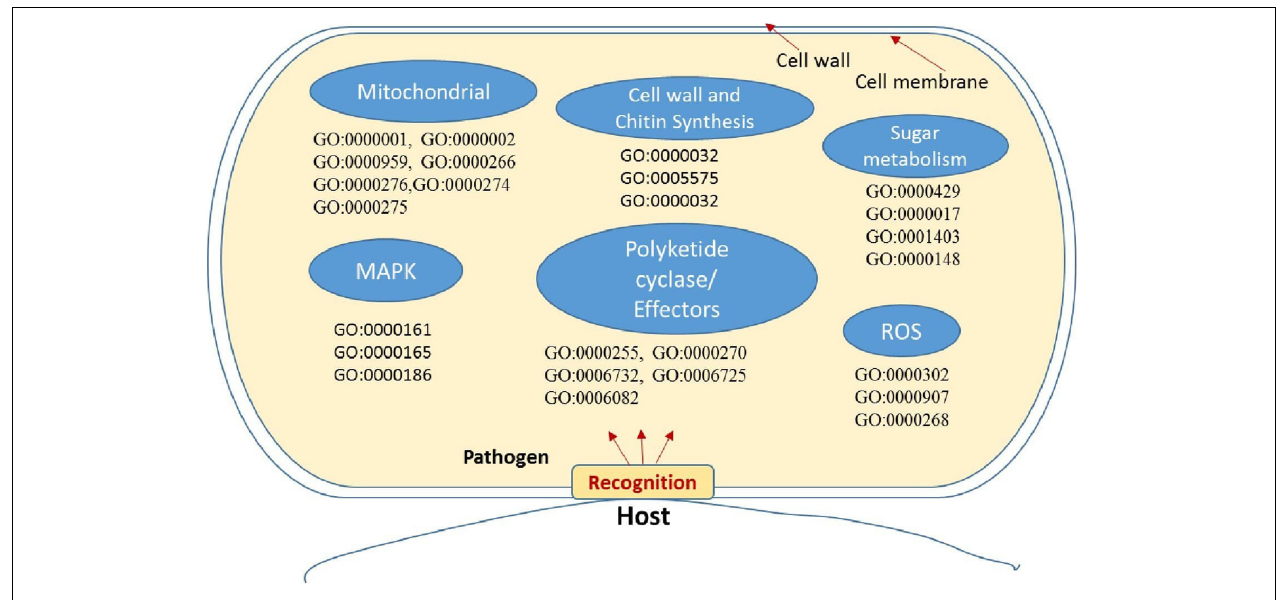
FIGURE 7 | Putative representation of possible activation of genes and GO enriched terms in fungal pathogen Bipolaris maydis in susceptible maize (CM 119) compared to resistant maize (SC-7) during early stages of infection. GO term and associated gene IDs are provided in Supplementary Table 7 .